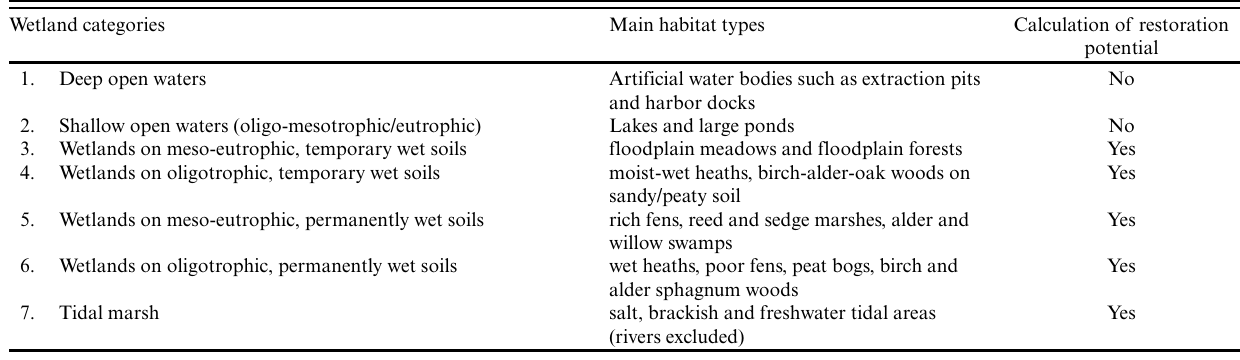
Table 1 . Wetland typology of the study, their encompassing habitat types, and indication whether or not potentials for restoration were